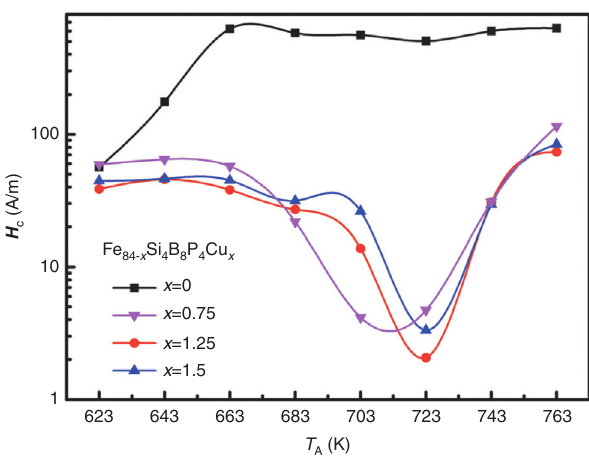
for Fe Si B P Cu alloys as a function of c 84- x 4 9 4 x